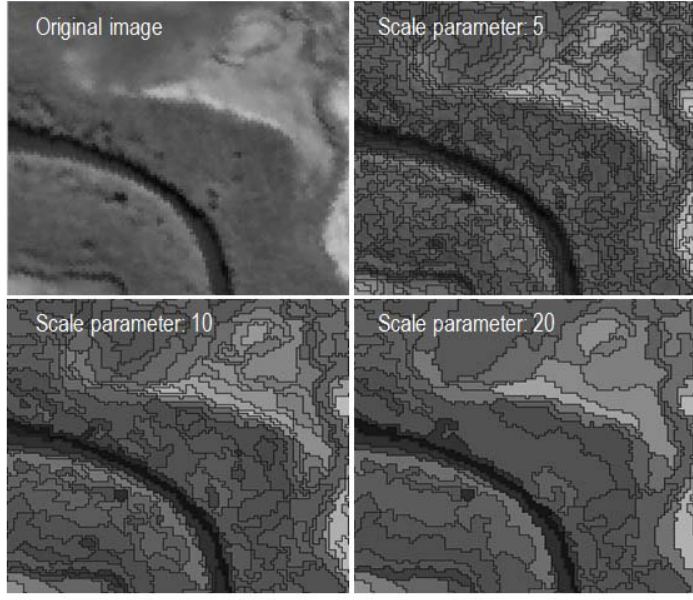
Figure 5. Example of image segmentation using three different scale parameters.